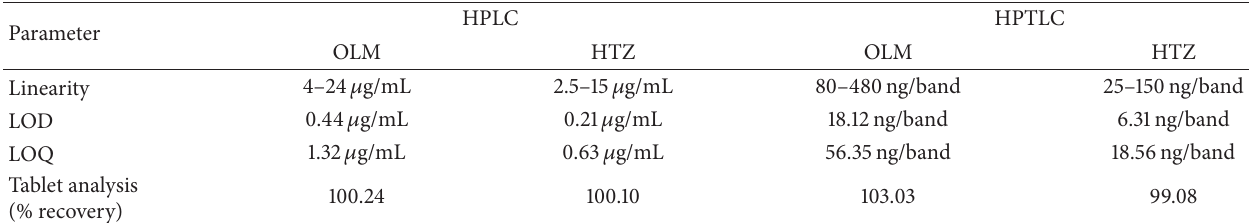
Table 7: Comparison of the proposed method with the reported HPLC